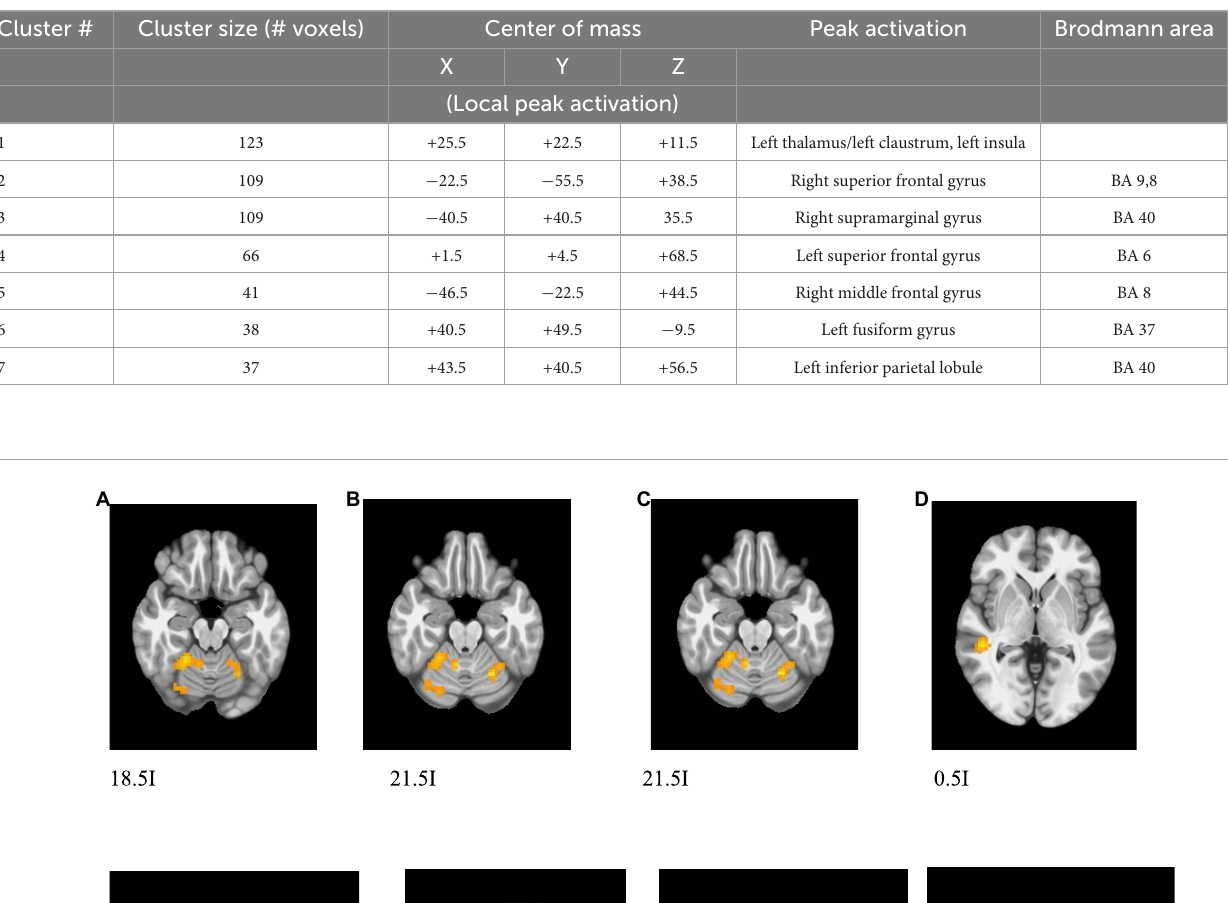
TABLE 2 Regions with significant group effect.